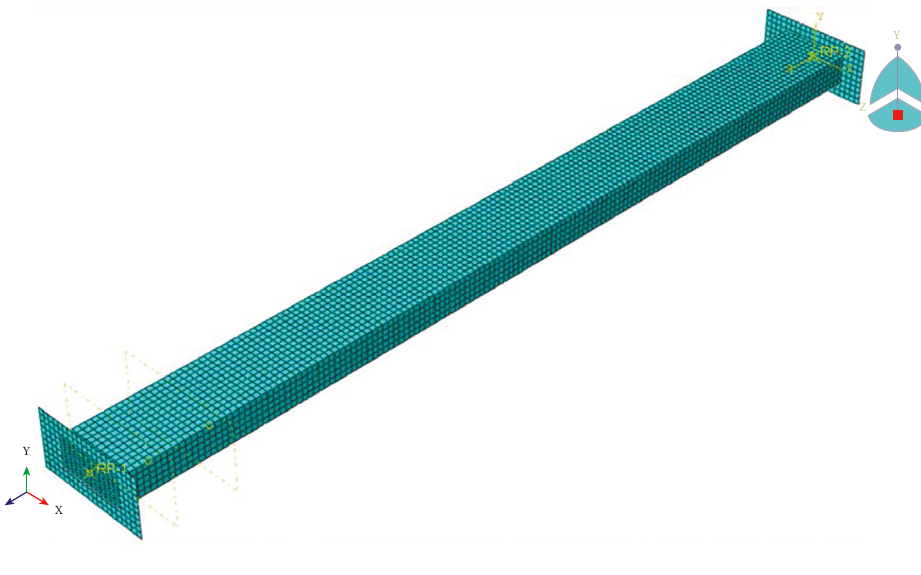
Figure 14: FEM model of the cold-formed thin-walled steel light-weight concrete built-up column.